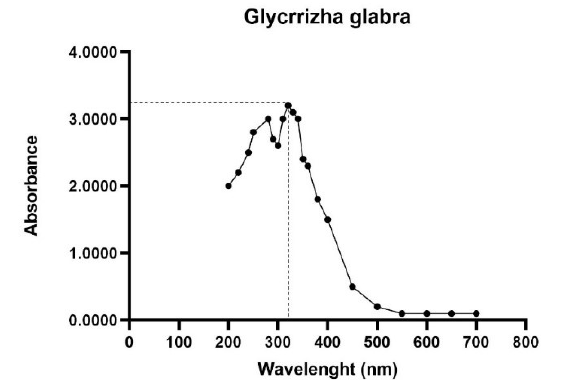
Figure 1. Absorption Extract Diagram of the Licorice Extract in the Range of 200-600 nm. Note. The highest absorption is related to the wavelength of 320 nm.